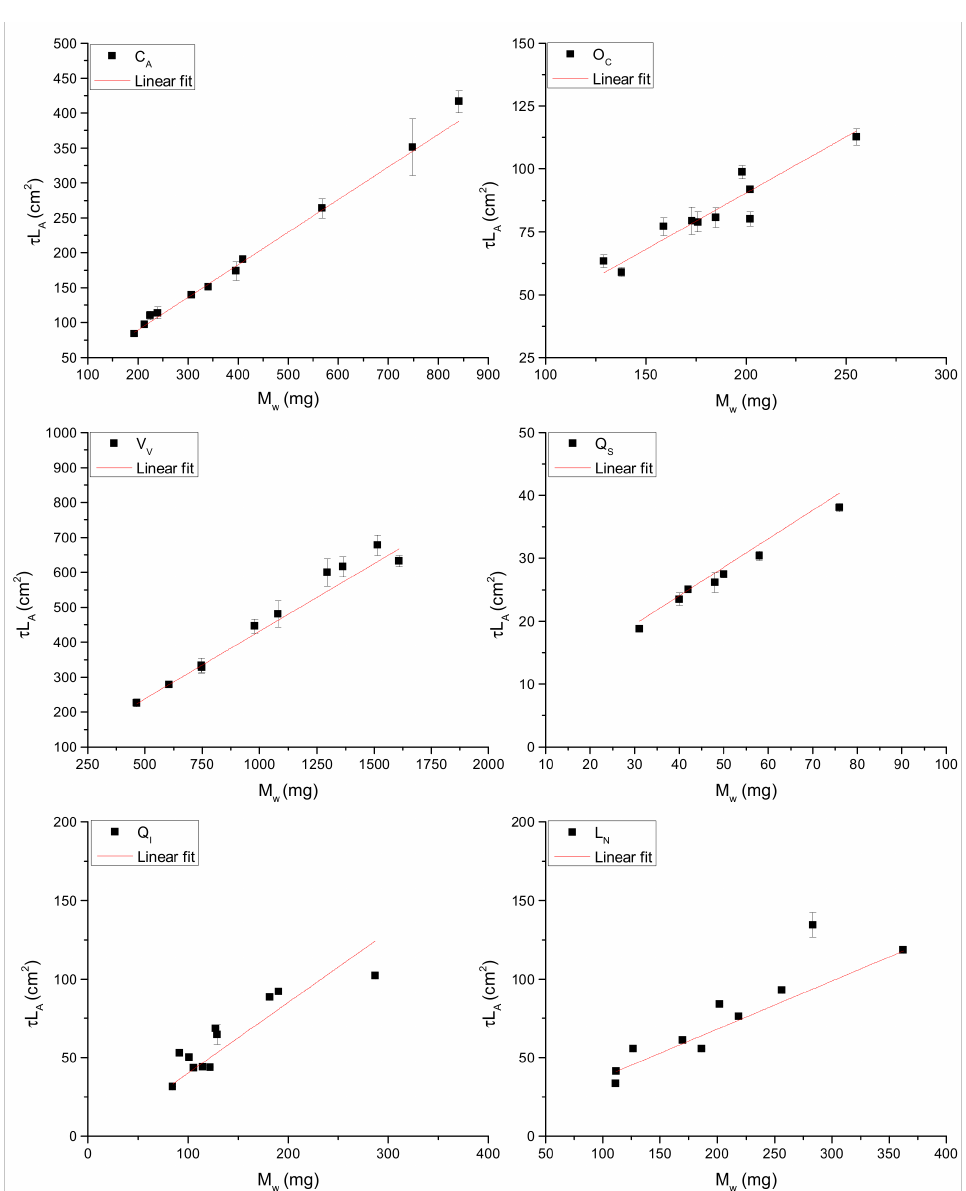
Figure 2. Relationships between the product of the leaf optical depth and the leaf surface area ( τ L A ) and the leaf water mass (M w ) with respect to the investigated